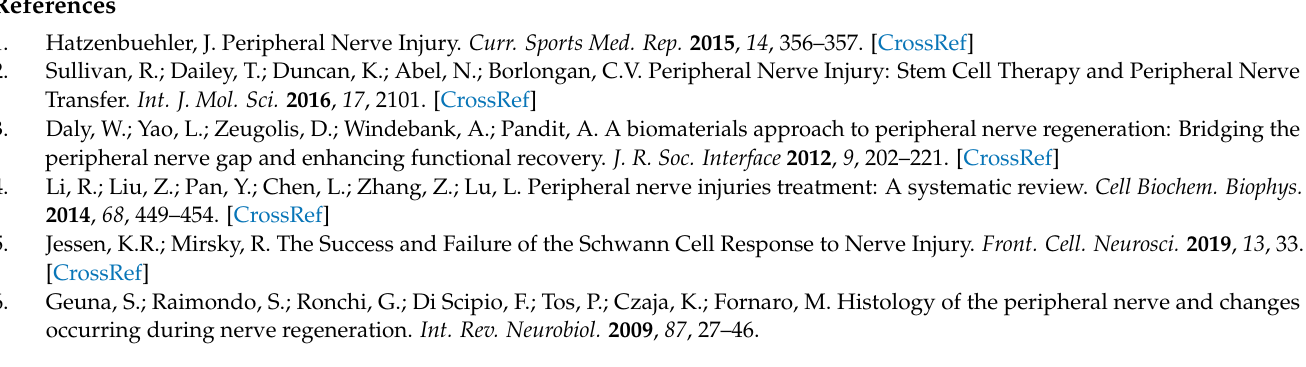
Schwann cells cultured on ISO, SCA and FLAT chitosan membranes, at 72 h. Figure S2: Merged confocal images of RT4-Schwann cells cultured on GR, ISO, SCA and FLAT chitosan membranes: actin fibers (red), N-Cadherin (yellow), nuclei (blue); scale bar = 20 µ m. Figure S3: Average cell